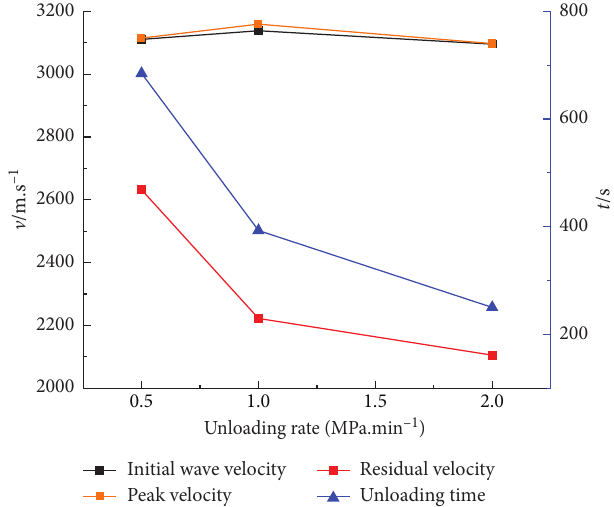
Figure 17: Relation curves of AW velocity and unloading rate.